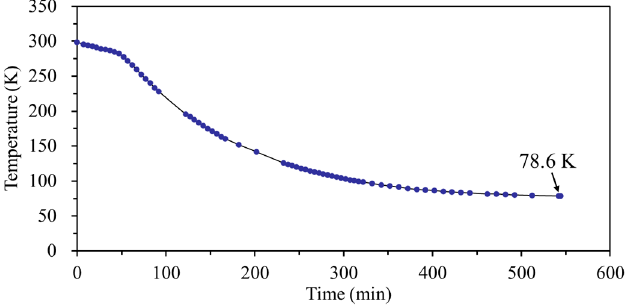
Figure 8. Temperature dropping process of the comb-drive actuator in the cryostat versus time flow.